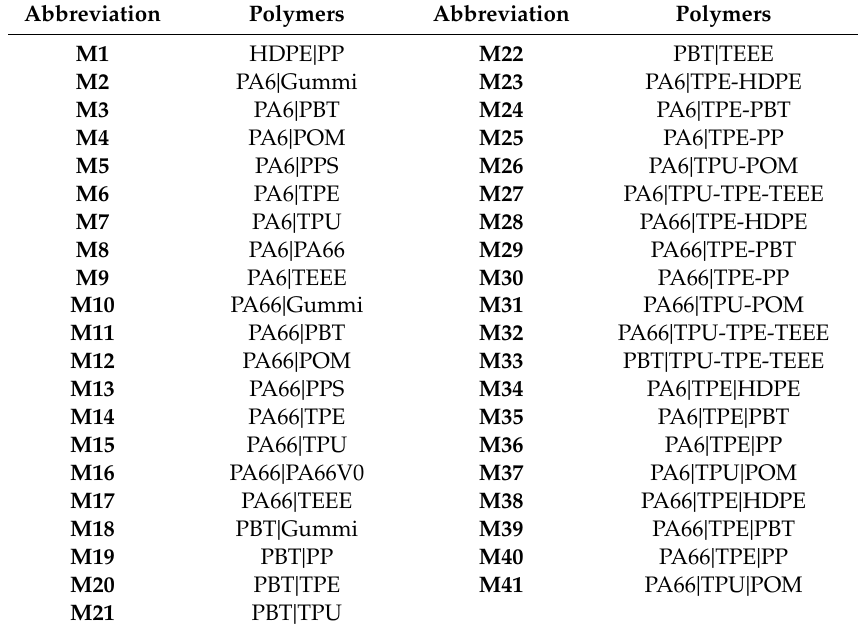
Table A3. Overview of the plastic mixtures considered for the classification